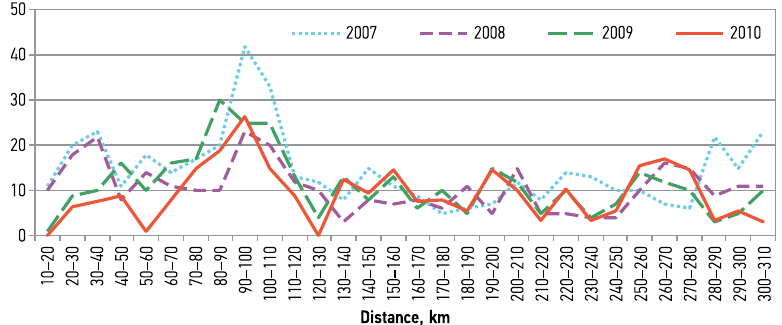
Fig. 3. Fluctuation of traffic accidents of the highway A1 in